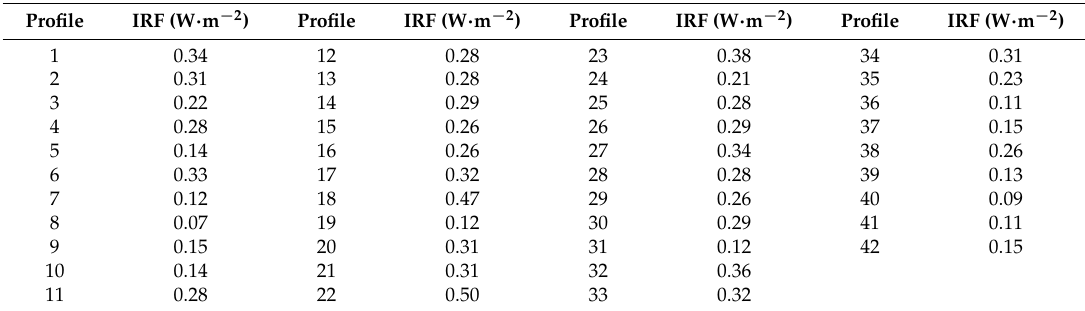
Table 6. NF 3 instantaneous radiative forcing at the top of the atmosphere in clear sky conditions in 42 atmospheric profiles with the concentration of 1.0